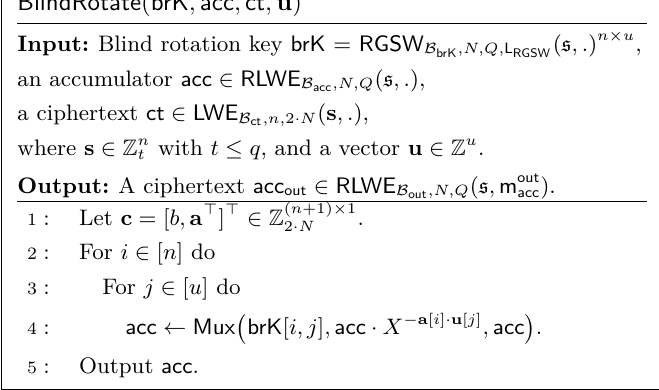
BlindRotate ( brK , acc , ct , u )